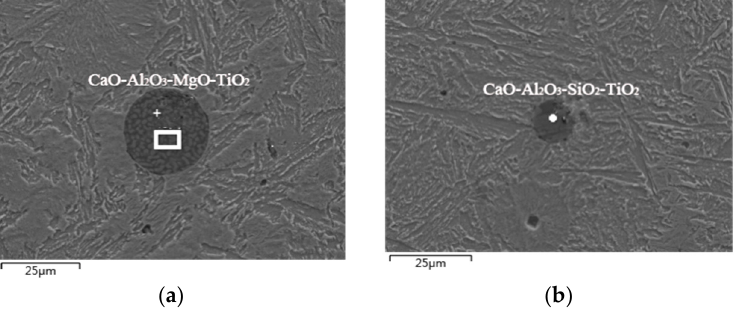
Figure 6. SEM and EDS analysis of inclusions before wire feeding. ( a ) CaO-Al 2 O 3 -MgO-TiO 2 ; ( b ) CaO- Al 2 O 3 -SiO 2 -TiO 2 .